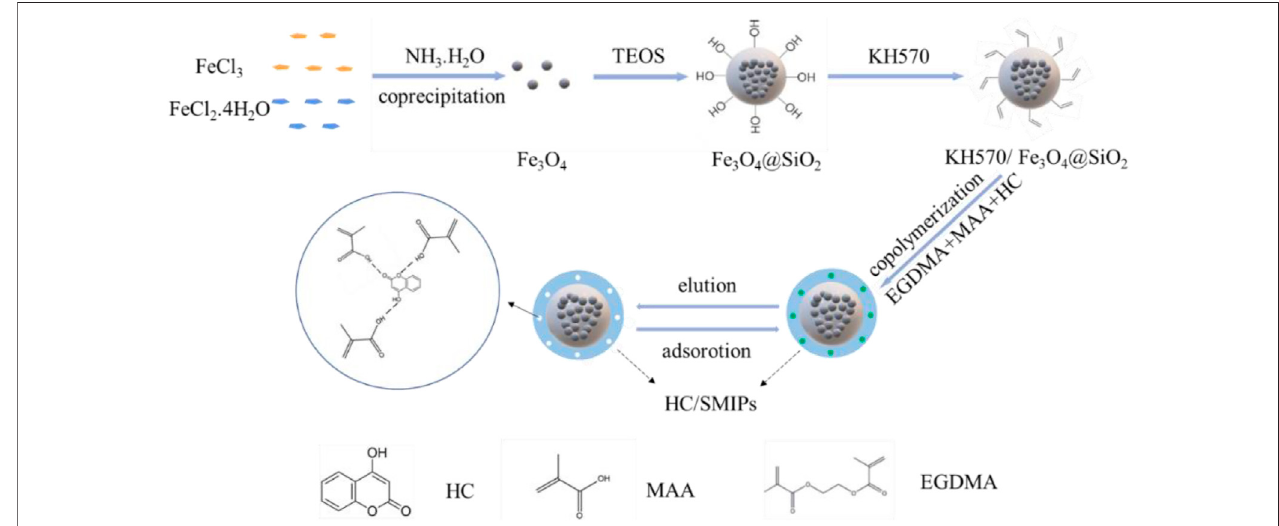
FIGURE 1 | Schematic illustration of the preparation procedure of HC/SMIPs.